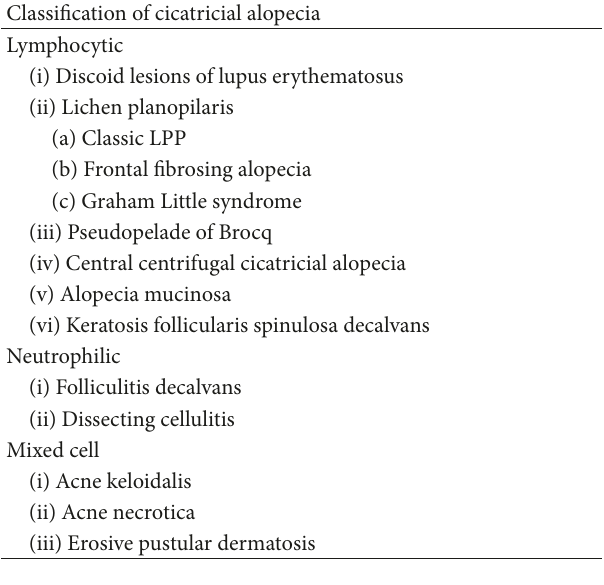
Table 1: Classification of primary cicatricial alopecia. Classification of cicatricial alopecia Lymphocytic